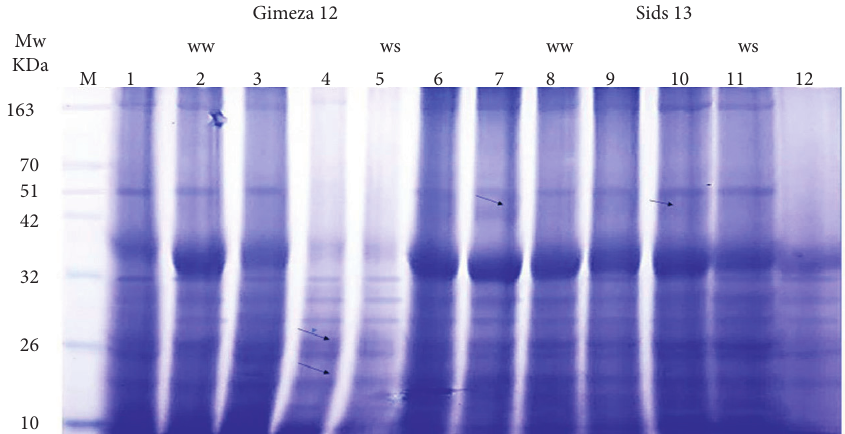
Figure 6: The change of protein bands (marked by arrowheads) in response to different treatments on wheat cultivars (Gimeza 12 and Sids 13) with nano-TiO 2 or nano-ZnO (10mg · L − 1 ) at different water irrigation requirements (WW and WS) at 75 days from sowing. Elec- trograph of soluble protein pattern by one-dimensional SDS-PAGE. Each lane contains equal amounts of protein extracted from the plant. Protein bands in the gel were visualized by Coomassie Blue stain. Lane M: Marker, Gimeza 12 (lane 1: WW, lane 2: WW +nano-TiO 2 , lane 3: